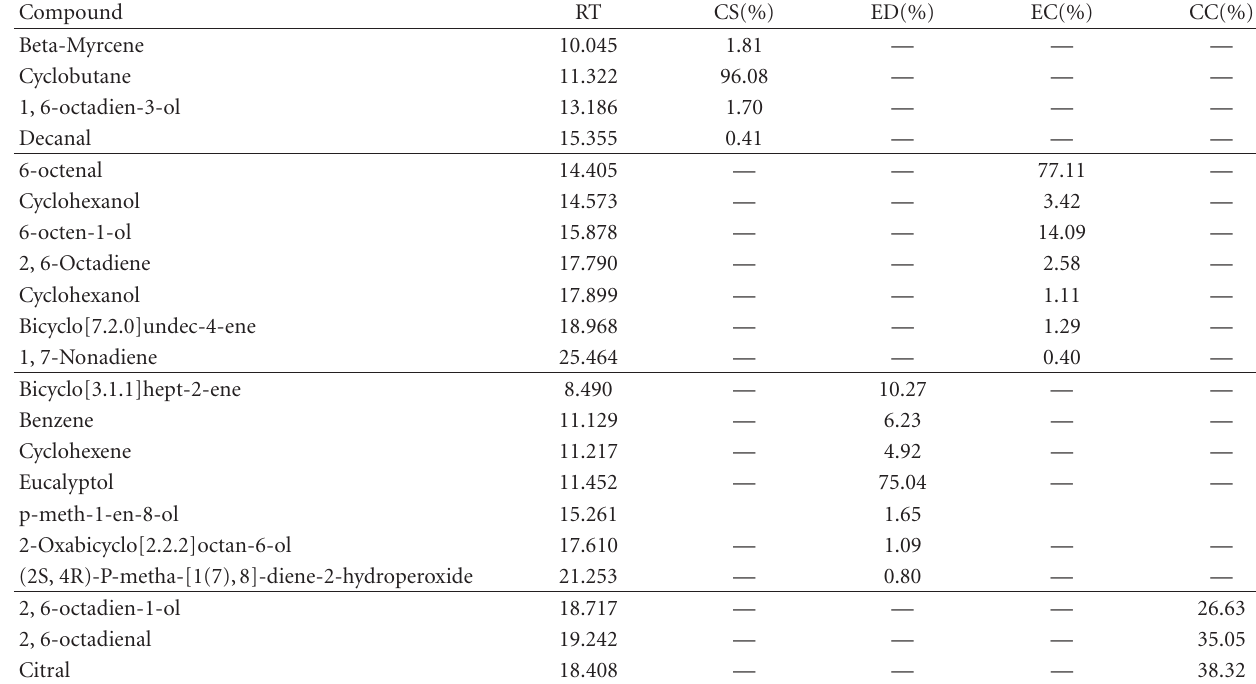
Table 1: GC-MS analysis for essential oils from CS, ED, EC and